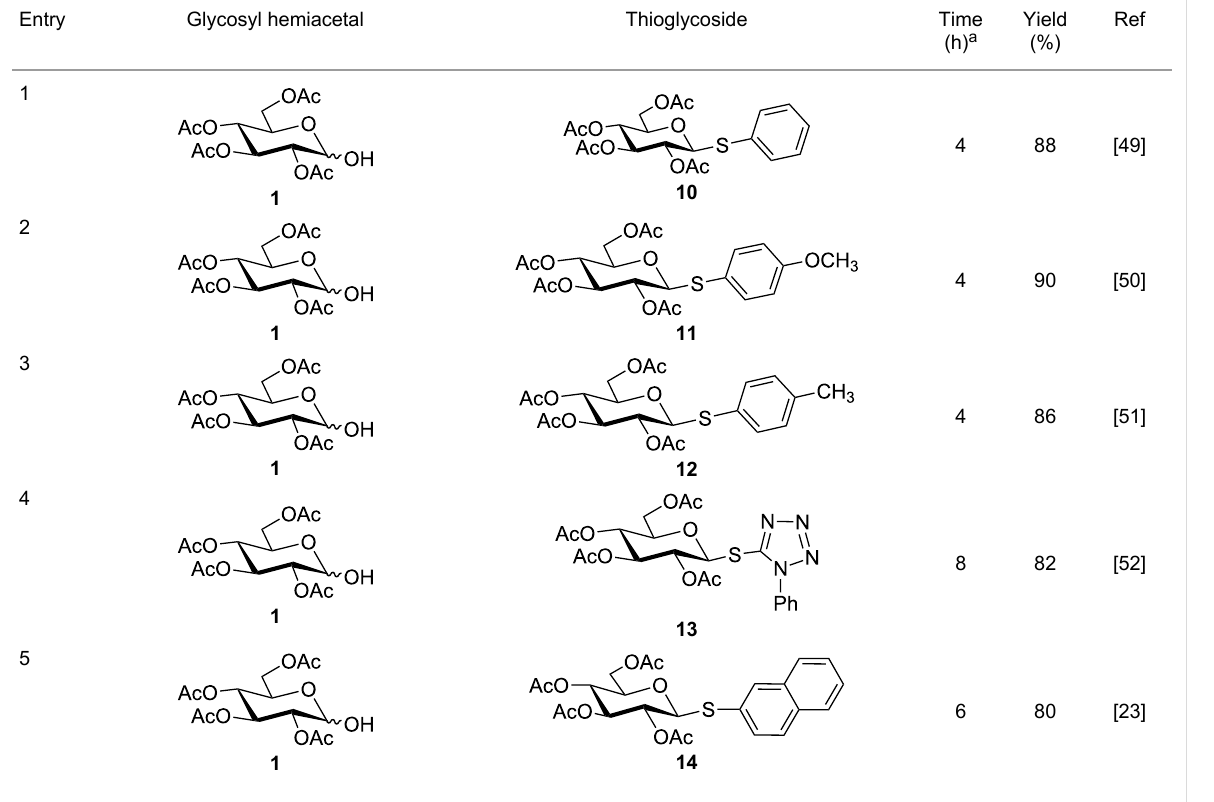
Table 3: Appel-reagent-mediated transformation of glycosyl hemiacetal derivatives to the thioglycosides at room temperature. Entry